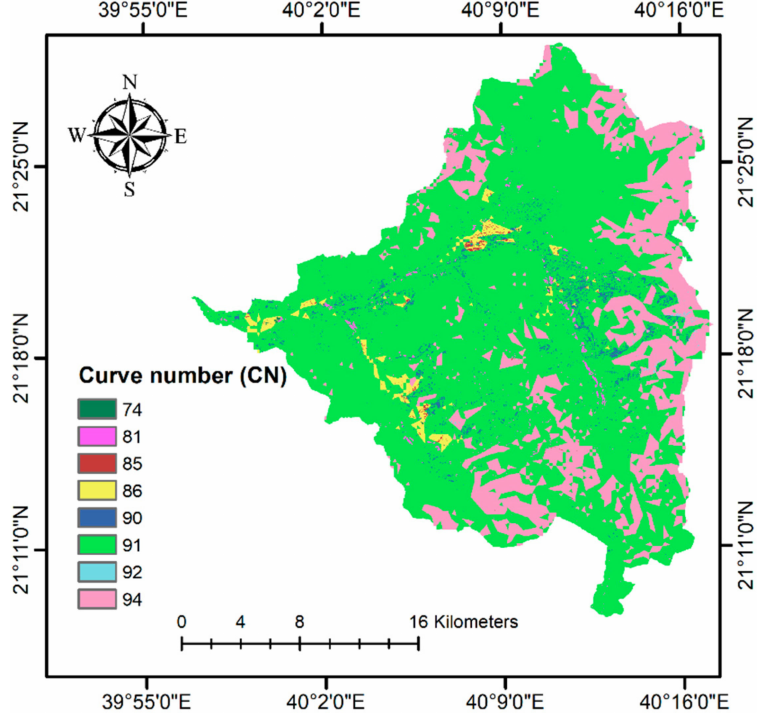
Figure 10. Distribution of curve number ( CN ) map in the study area.